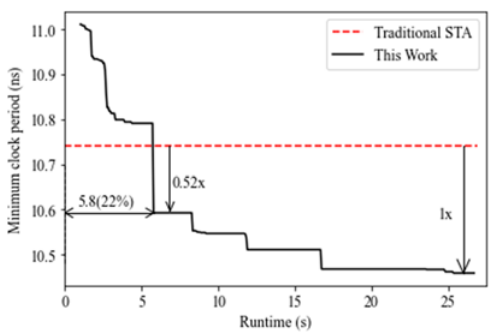
Figure 13. The objective trace during the optimization on s38584.